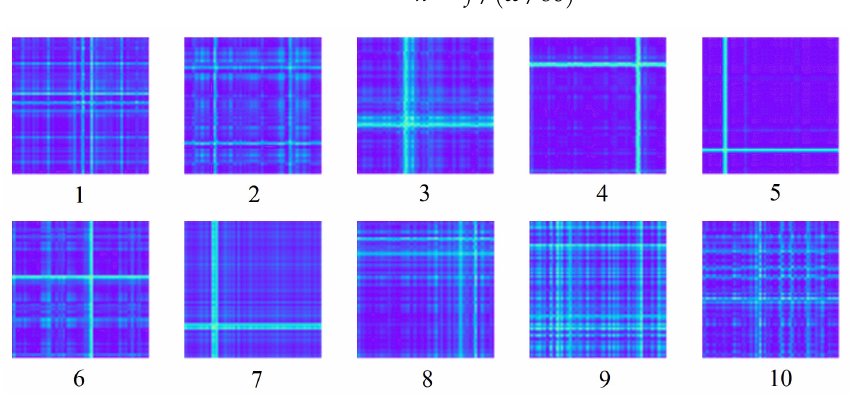
Figure 21. The GAF images of dataset B.